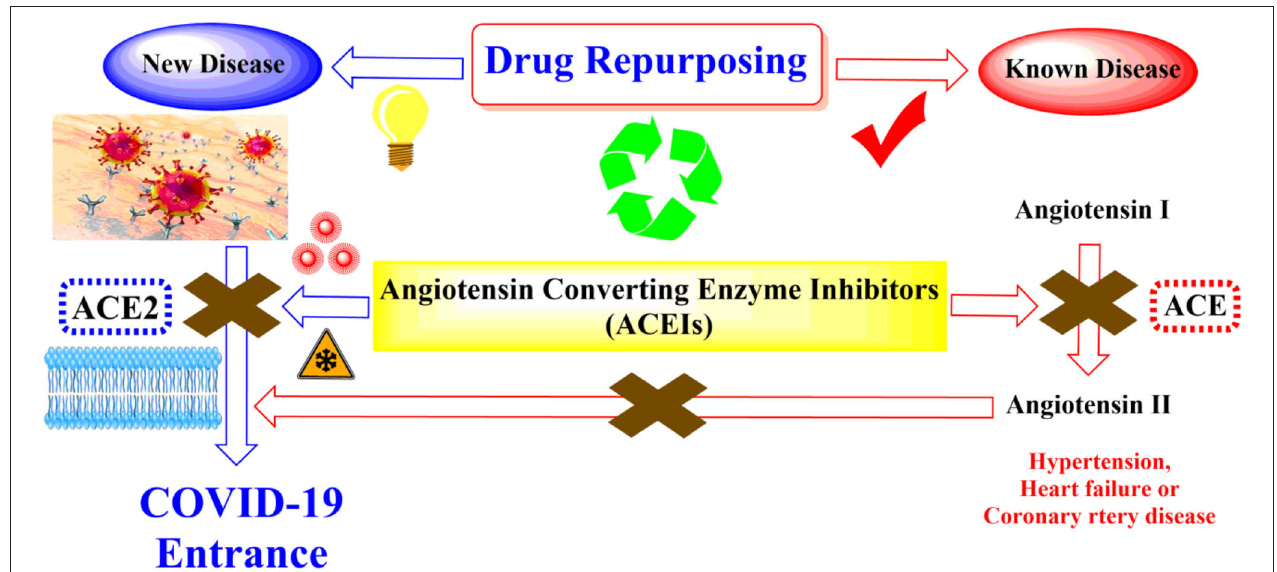
FIGURE 2 | Schematic representation showing the idea of repurposing the FDA-approved ACEIs as COVID-19 entrance inhibitors through the inhibition of the hrs ACE2 receptor.